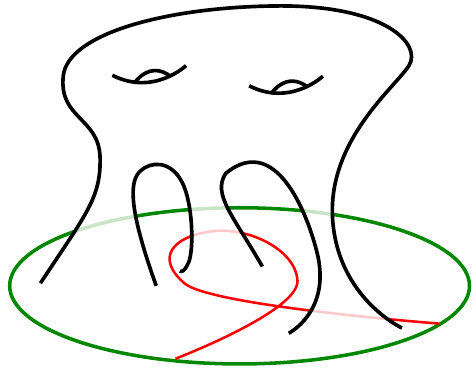
Figure 8 . An example of a genus 4 geometry with a self-intersecting geodesic. Cutting along the geodesic results in a geometry with three boundaries and genus